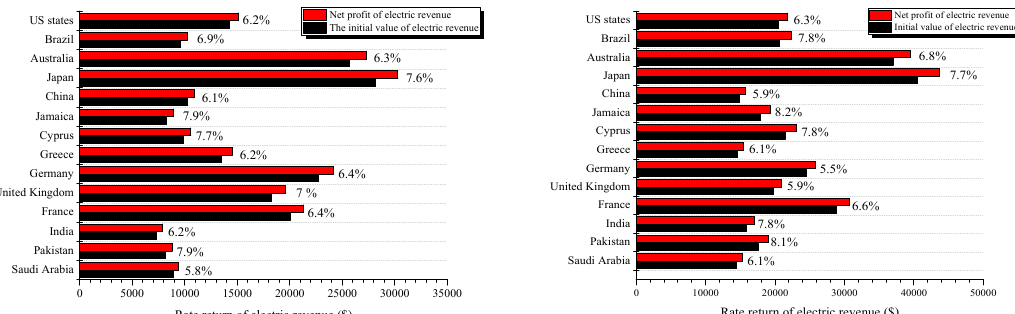
Figure 14. The increase in rate returns of electric revenue associated with the 18-kW and 43-kW 10 × 10 PV arrays, taking into account the greatest economic advantage per year. Table 13. The original and final rate returns associated with the substituting modules of the 10 × 10 PV arrays, taking into account the greatest economic advantage per year.